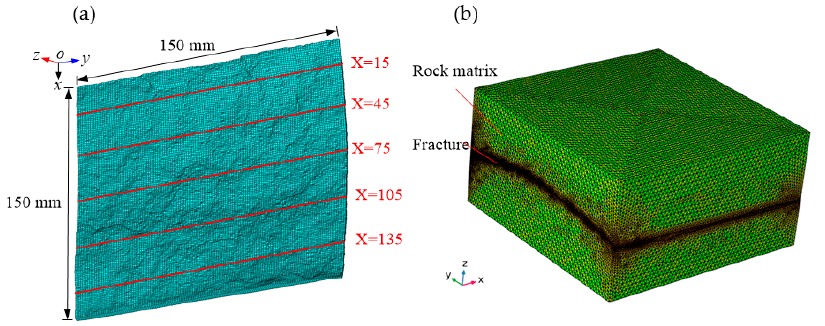
Figure 7. The 3D fracture model setup scanned by stereotopometric scanning system. ( a ) 3D frac ‐ ture geometry model. ( b ) 3D fracture mesh model. geometry model. ( b ) 3D fracture mesh